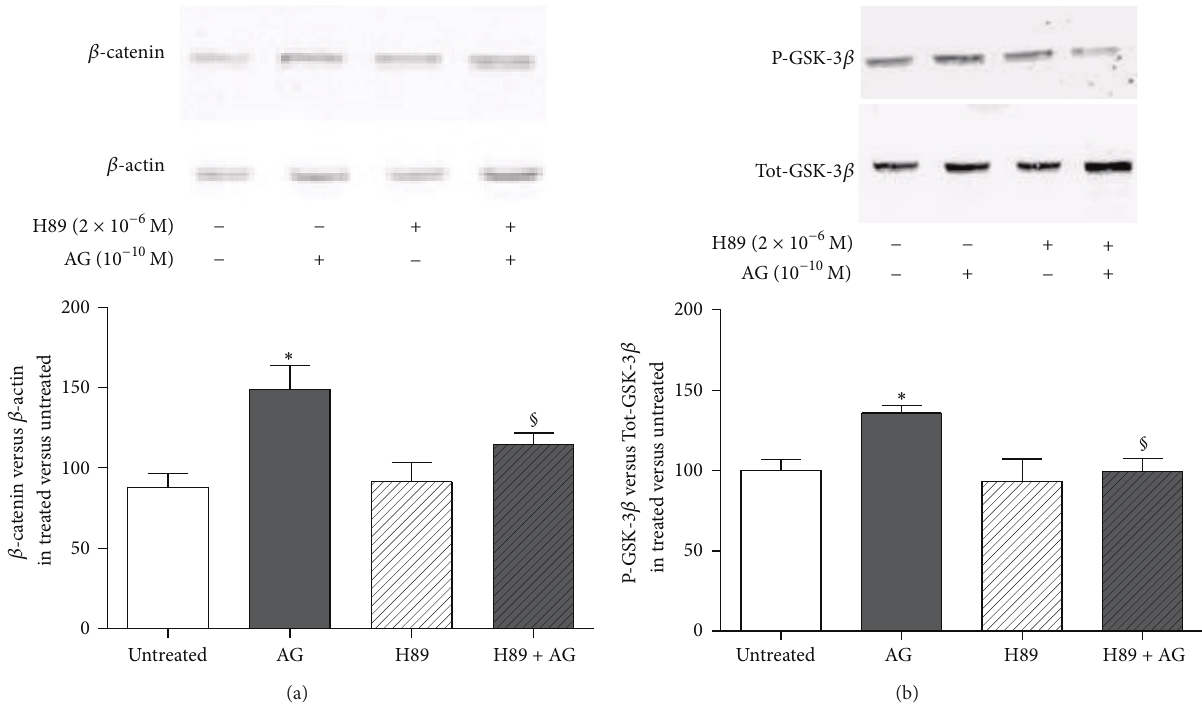
Figure 4: Effect of the pretreatment with the PKA inhibitor H89 ( 2×10 −6 M, 30 min before) on (a) 𝛽 -catenin and (b) phosphorylated-GSK3 𝛽 (P-GSK3 𝛽 ) levels measured in whole cell lysates by Western blot on rat osteoblast-like cells (rOB) treated with ghrelin (AG, 10 −10 M for 1h). 𝛽 -catenin levels were normalized to 𝛽 -actin levels; P-GSK3 𝛽 was normalized to total GSK3 𝛽 levels (Tot-GSK3 𝛽 ). Results are expressed as ratio of 𝛽 -catenin or P-GSK3 𝛽 measured in treated cells versus untreated cells. Insets : typical gels obtained from rOB cell lysates after treatment with ghrelin alone or together with H89. Data are the mean ± SEM of 5 experiments ∗ 𝑃 < 0.05 versus untreated cells; § 𝑃 < 0.05 versus AG treated